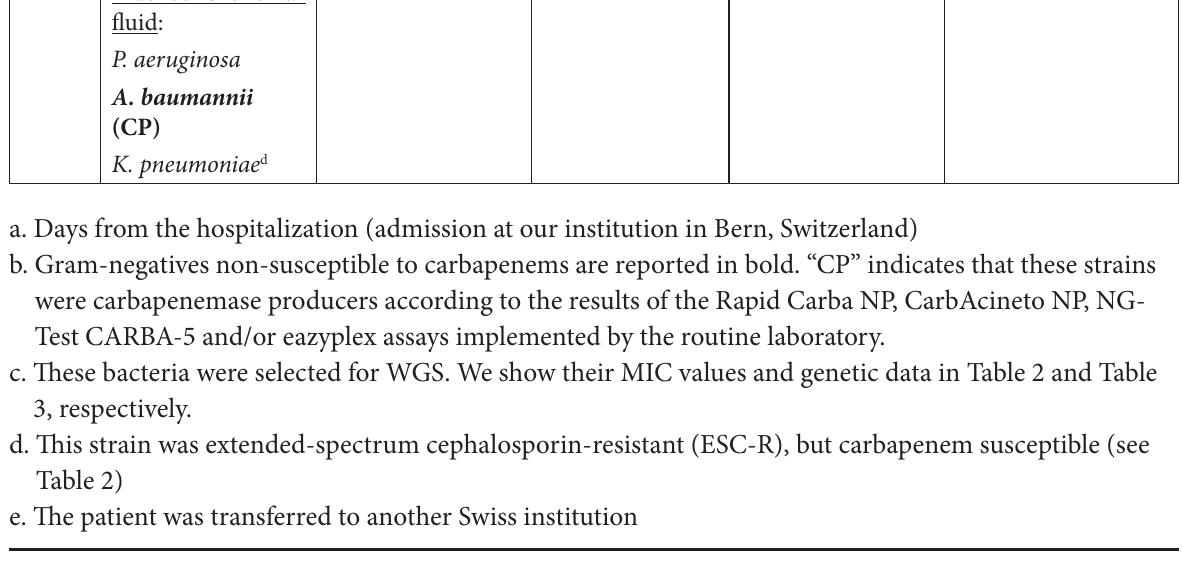
Table 2. Phenotypic characterization of the 6 Gram-negatives isolated from the same patient